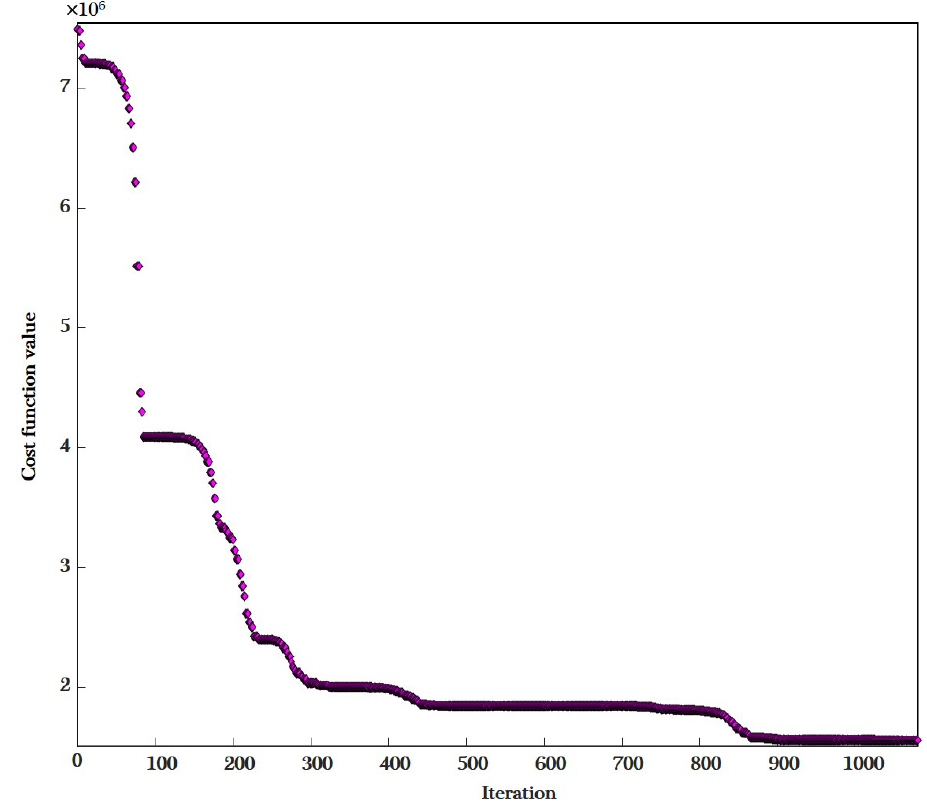
Figure 5. The figure shows variations of the cost function value during the training of the multiple non-linear regression model, using Algorithm 1. The value of the cost function is calculated by using Equation 7. Equation